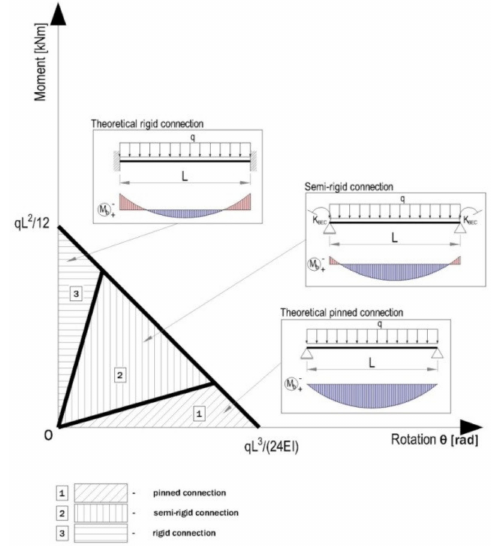
Figure 8. Classes of the beam-end-connections related to the rigidity, according to EN 1993-1-3